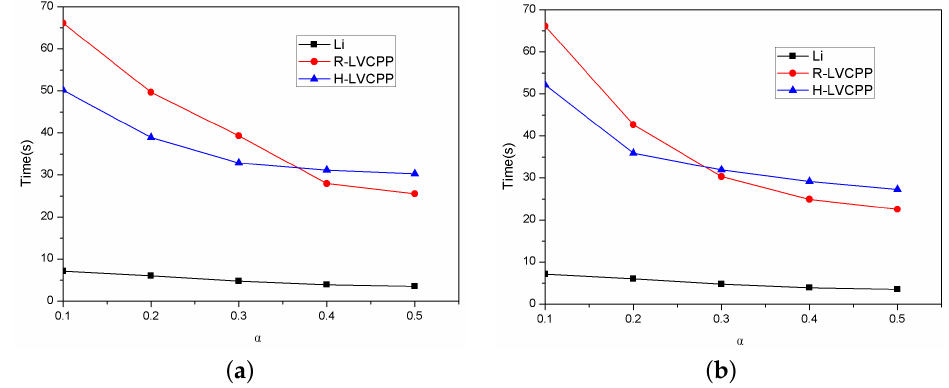
Figure 3. Running time evaluation under different α : ( a ) Brightkite; ( b )